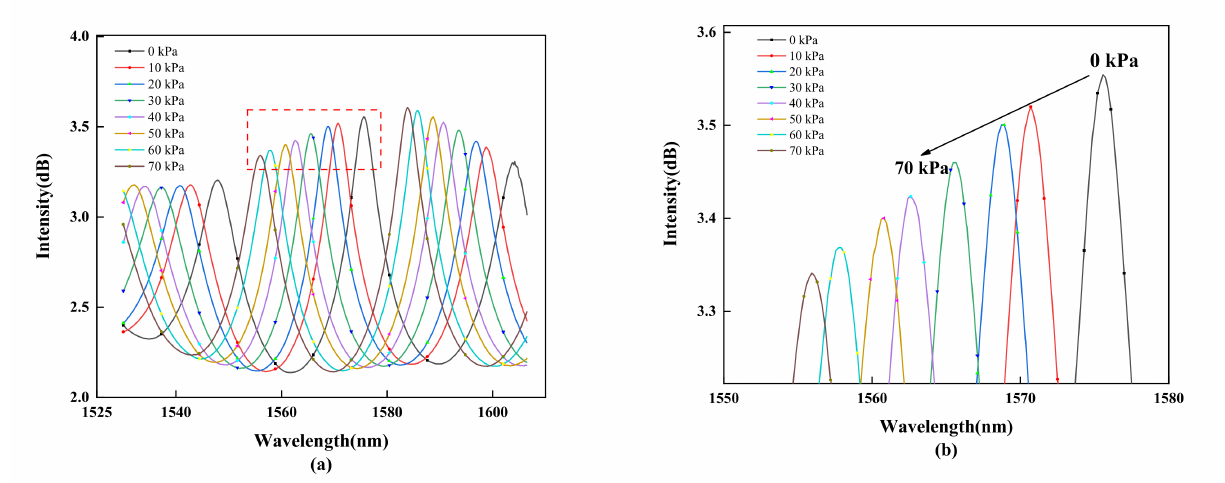
Figure 9. Interference spectrum movement under pressure change of 0–70 kPa: ( a ) interference spectra at the 75 nm band; and ( b ) local enlargement of one interference